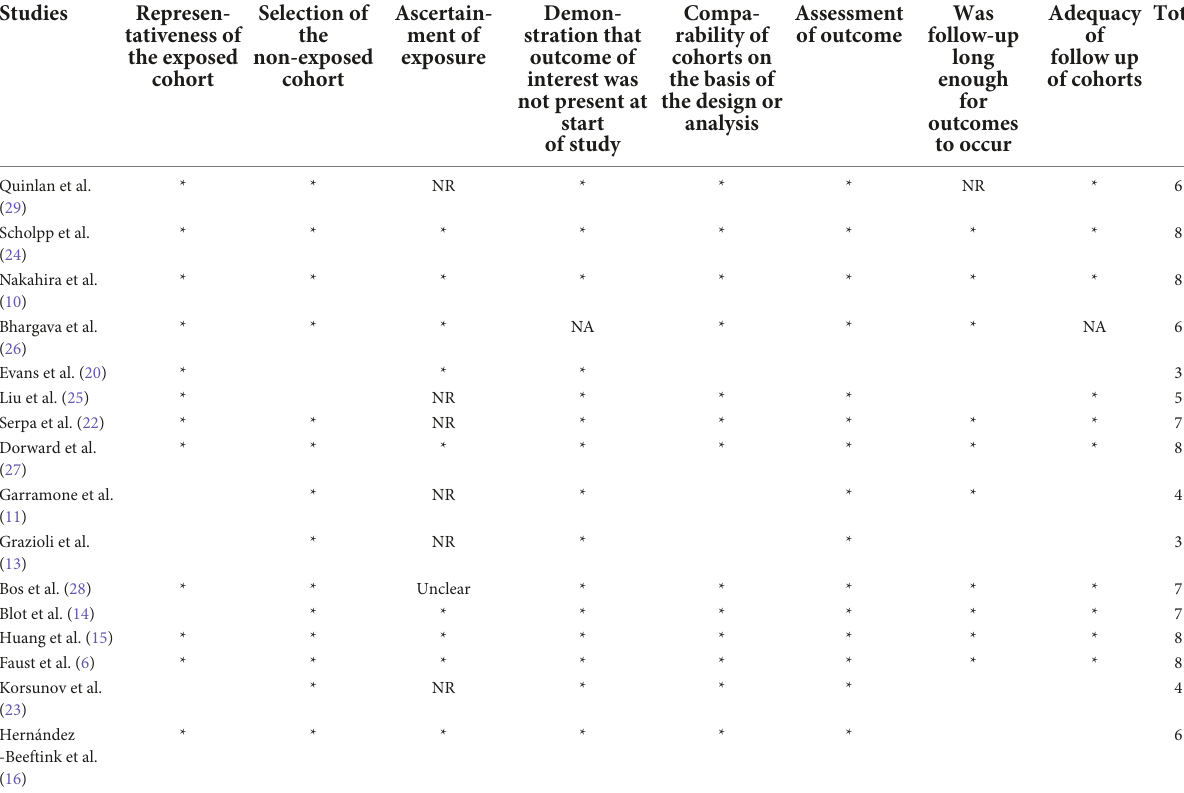
TABLE 7 Quality assessment Newcastle-Ottawa scale table for non-RCT studies. Studies Represen- tativeness